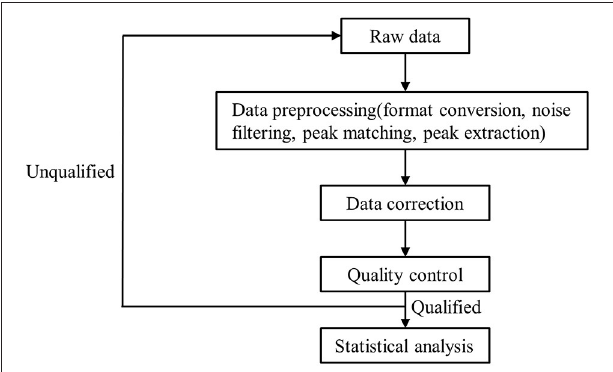
FIGURE 1 | The flow chart of raw data processing.